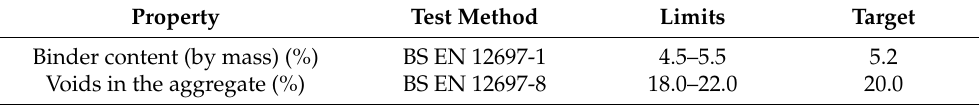
Table 2. Asphalt mixture